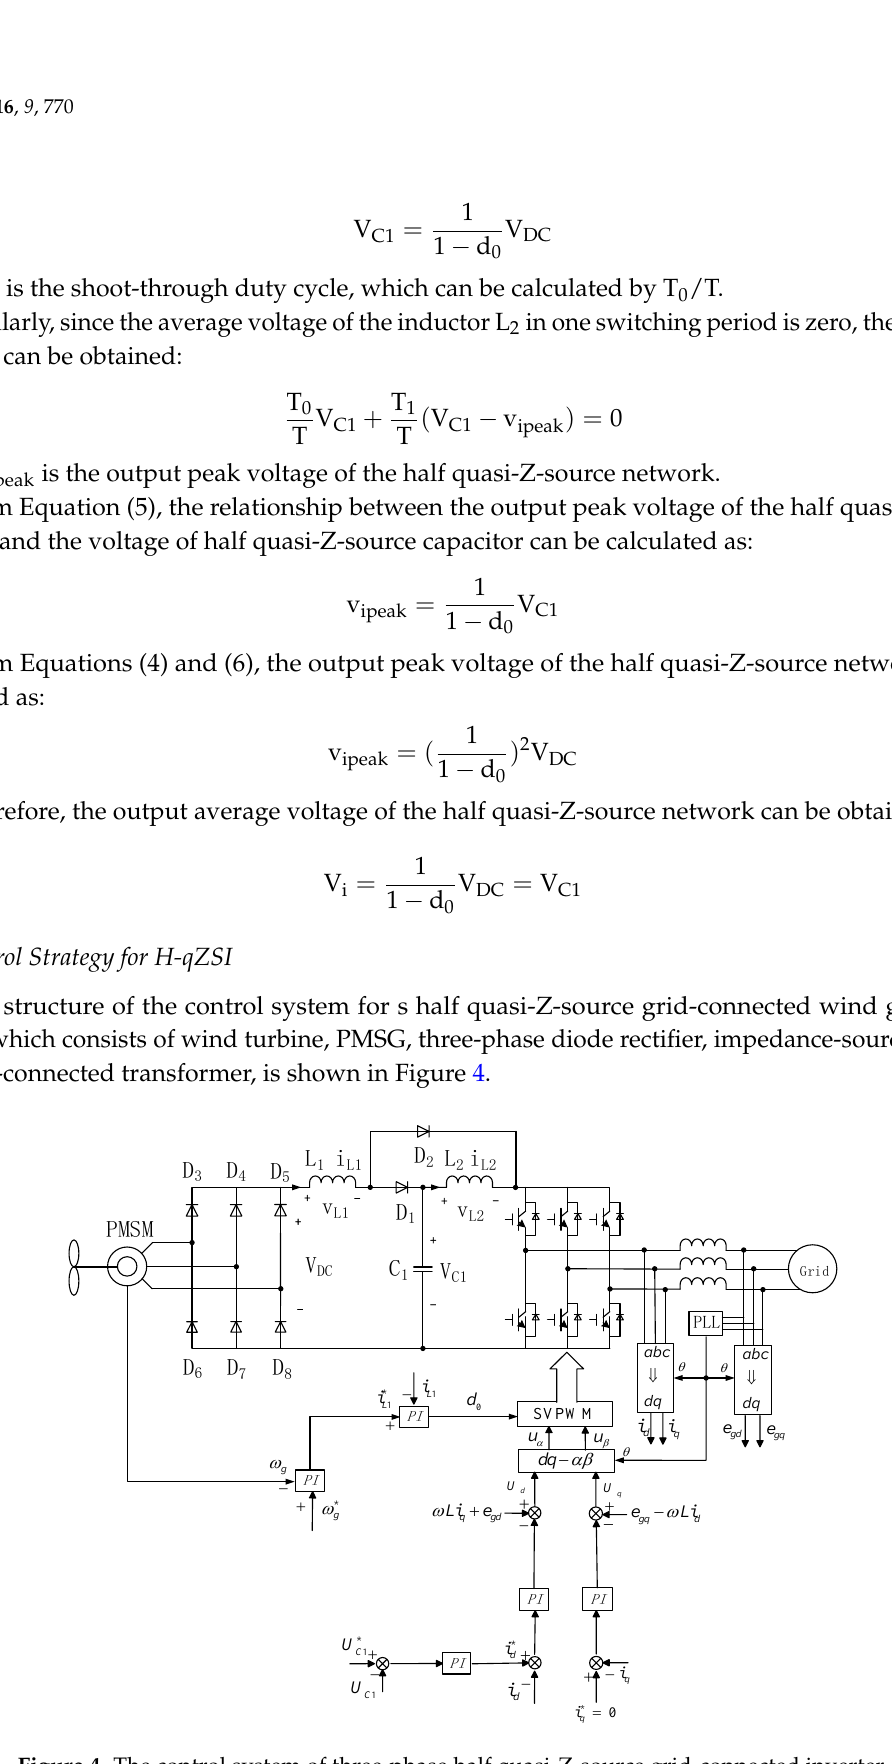
Figure 4. The control system of three-phase half quasi-Z-source grid-connected inverter. The d-axis of the d and q coordinates is made to coincide with the grid voltage vector. Thus, active and reactive power control can be achieved by controlling the d-axis and q-axis component